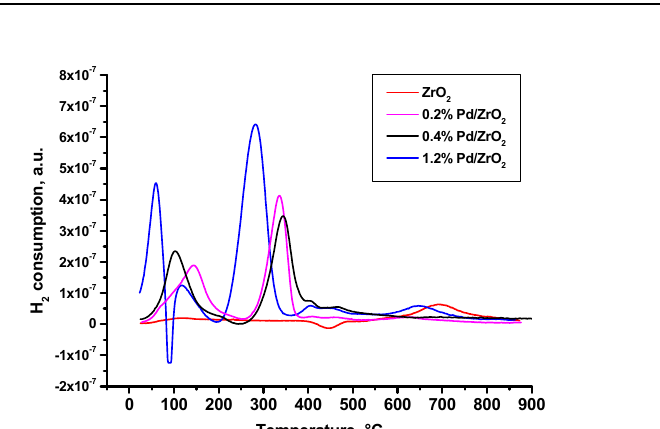
Figure 2. Temperature-programmed reduction profiles for the pristine ZrO 2 , and samples 0.2% Pd/ZrO 2 , 0.4% Pd/ZrO 2 and 1.2% Pd/ZrO 2 . All samples were dried at 110 °C and calcined at 500 °C.